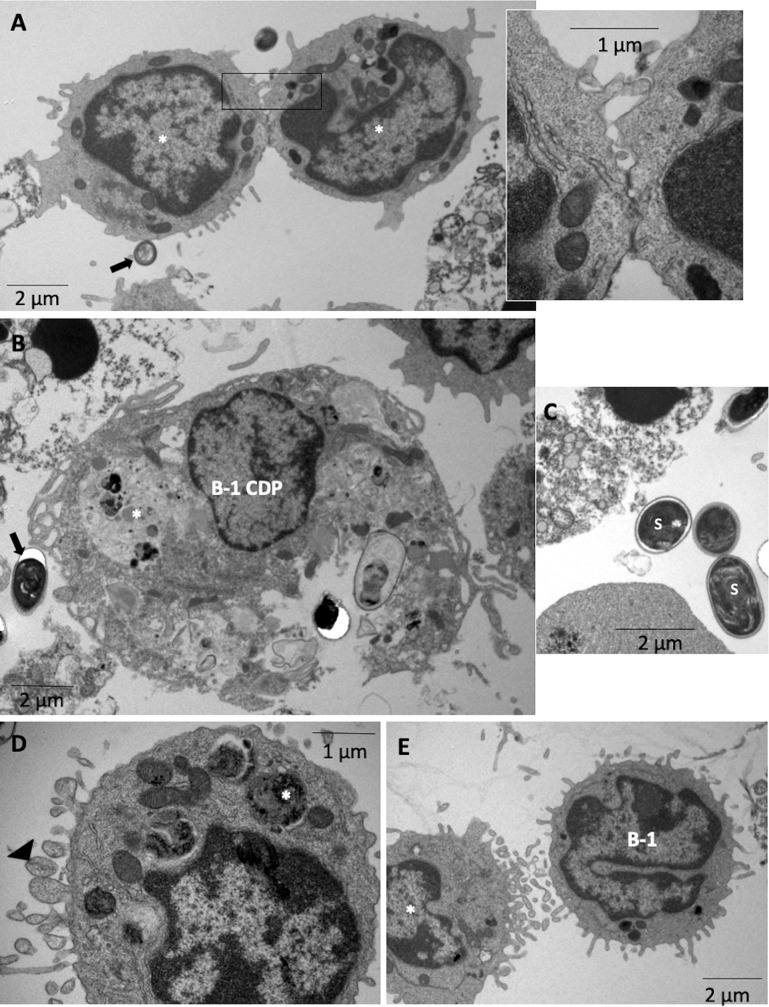
Phagocytic activity of B-1 CDP culture after 1 h and 48 h of infection with E. cuniculi by ultramicrography.(A) Pre-B-1 CDP (*) in communication between them and with E. cuniculi spores (arrow). Amplified view of the interaction between B-1 cells. (B) B-1 CDP with the presence of amorphous material inside phagocytic vacuoles (*). (C) Non-germinated spores (s) outside the cells with a thick wall composed of two layers and a plasma membrane. (D) Extracellular vesicles (head arrow) in the membrane of pre-B-1 CDP with the presence of amorphous material (*) inside. (E) Extracellular vesicles in membranes of pre-B-1 CDP (*) and B-1 cell.